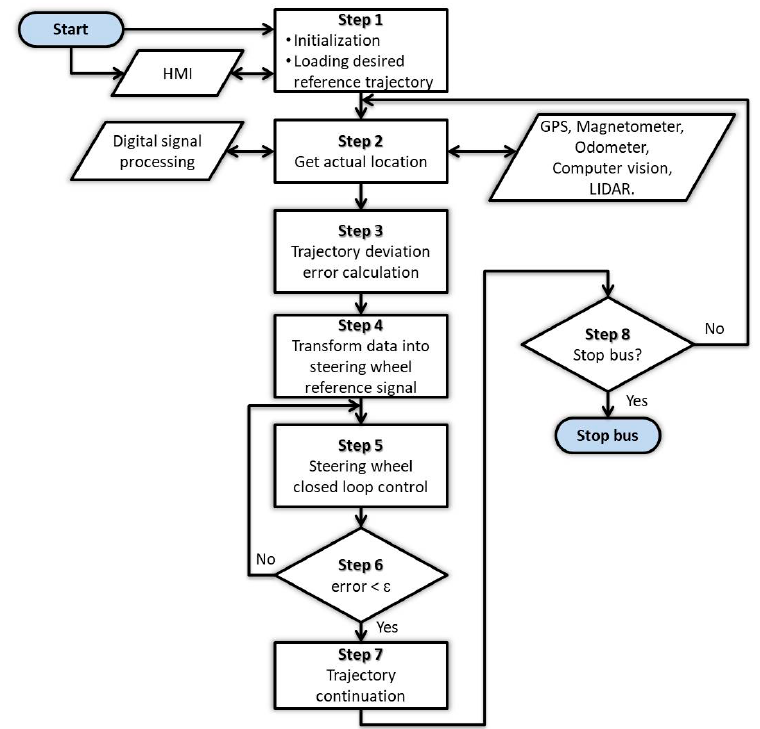
Figure 6. Implemented flowchart for steering control.